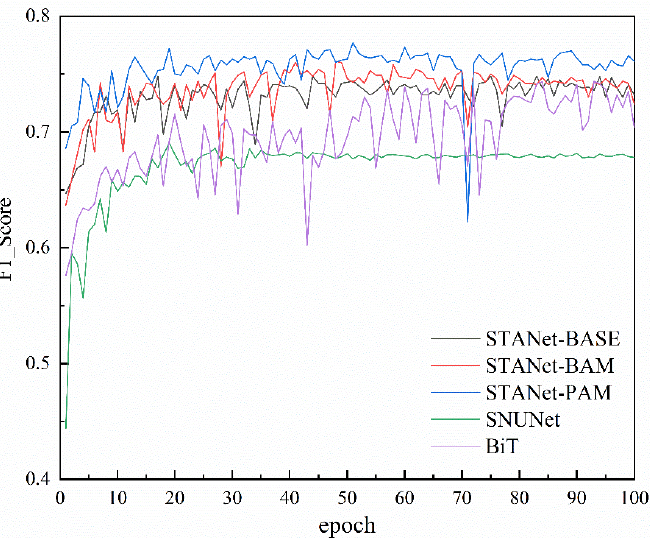
Figure 4. The F1_Scores of the STANet-BASE, STANet-BAM, STANet-PAM, SNUNet, and BiT. Each epoch contains 1000 iterations.